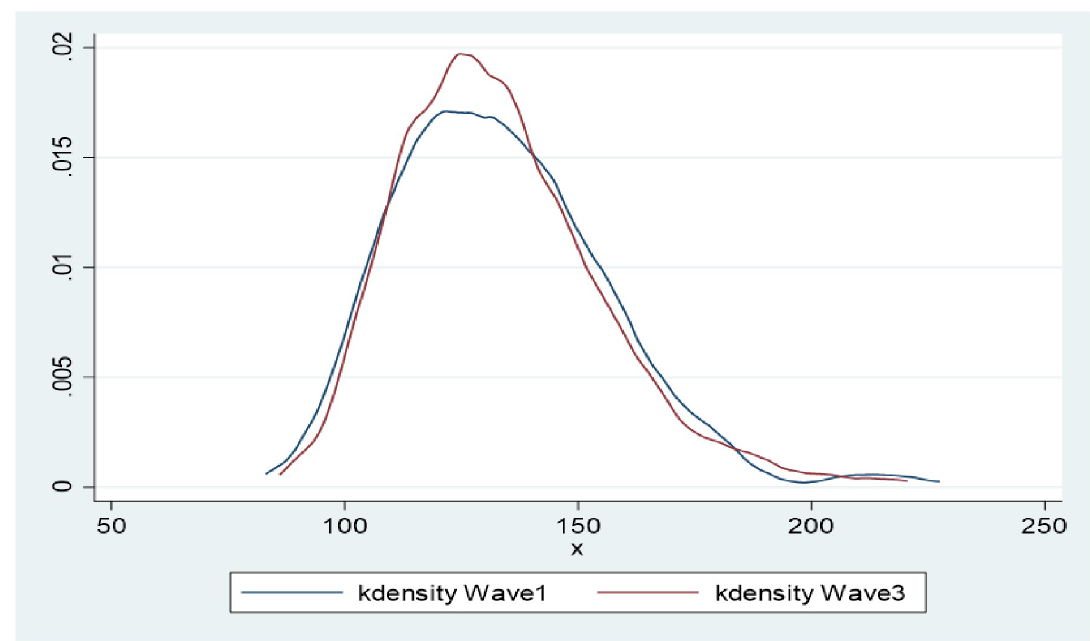
Fig 2. Non-parametric kernel-density estimates for the distribution of SBP (W1, W3 n = 820).